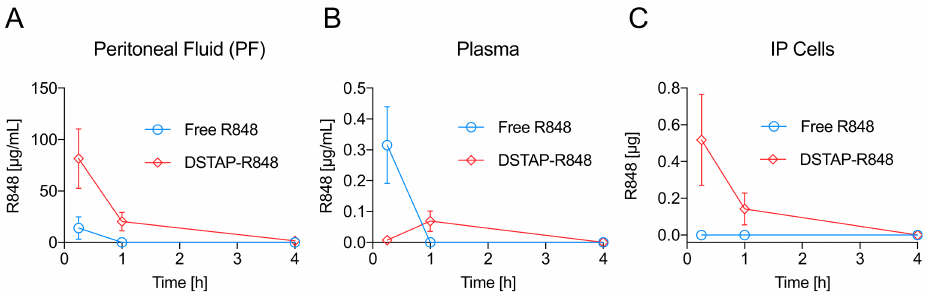
Figure 1. R848 concentrations in the ( A ) peritoneal fluid, ( B ) plasma, and ( C ) IP cells after IP administration (1 mg/kg) of free R848 or DSTAP-R848 in mice. (Data = mean ± SD, n =